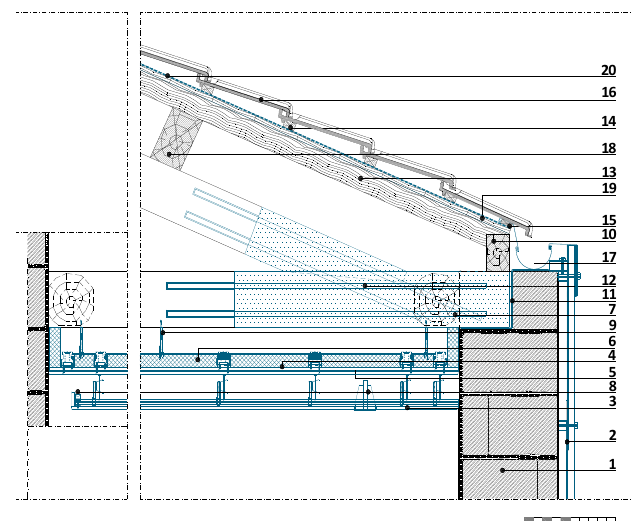
Figure 3. SIF2—intervention solution. 1. stone masonry wall; 2. galvanized steel plate; 3. decorative suspended ceiling to be defined; 4. type A, STD, or H 12.5 mm thick double plasterboard panel; 5. top surface elastomer membrane at 3 kg/m²; 6. mineral wool panel with 70 kg/m³ density; 7. beam for support of the roof structure; 8. lighting (built into the panel or hidden in cove); 9. metal kingpost; 10. Transom; 11. application of waterproofing coating, e.g., polymer-based bituminous course; 12. repair and reinforcement with fiberglass- or polyester- or epoxy resin paste-type epoxy products and embedded stainless steel bars; 13. rod or rafter; 14. Batten; 15. eaves beam; 16. Marseilles tile; 17. zinc gutter and flashing; 18. purlin (box section); 19. wooden lining; 20. water vapor flexible membrane (eventually).